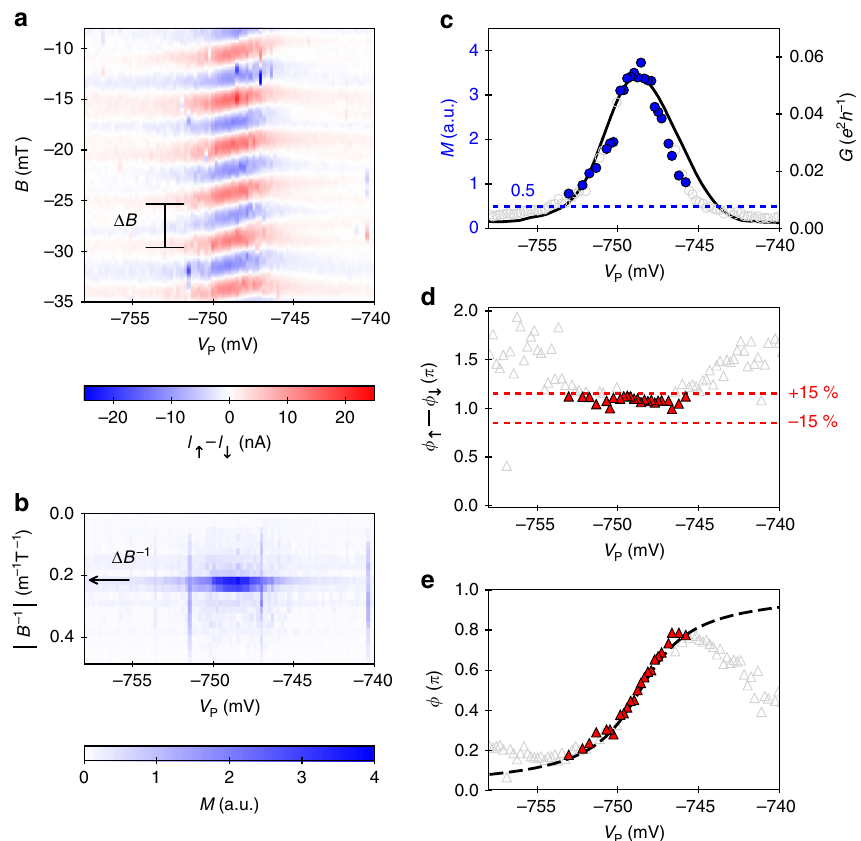
Fig. 7 Exemplary set of raw data with analysis. a Difference of currents, I ↑ − I ↓ , as a function of magnetic fl ux density, B , and the plunger gate voltage, V P . b Magnitude of AB oscillation, M , obtained by Fourier analysis with respect to B . The arrow indicates the periodicity of the AB oscillation, Δ B . c Slice of M at Δ B (left axis; blue points) and electrical conductance through the quantum dot (right axis; black line) as a function of V ϕ ↑ P . d Difference of the AB phases, − ϕ ϕ , (red points) as a function of V – Wigner pro fi le based on a ↓ . e Transmission phase, P . The dashed line indicates the evolution expected from a Breit Lorentzian fi t of G see data ( c ). Data points not ful fi lling our quality criteria are shown as open, grey